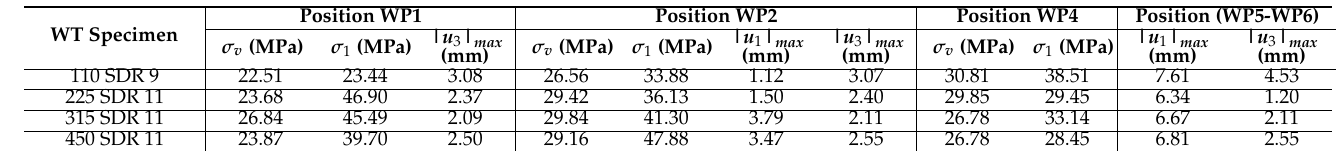
Table 9. σ v , σ 1, u 1 , and u 3 values at selected positions (Figure 12c) along the longitudinal direction from the center of the BF joint to the tip of the TWT specimens at F max .